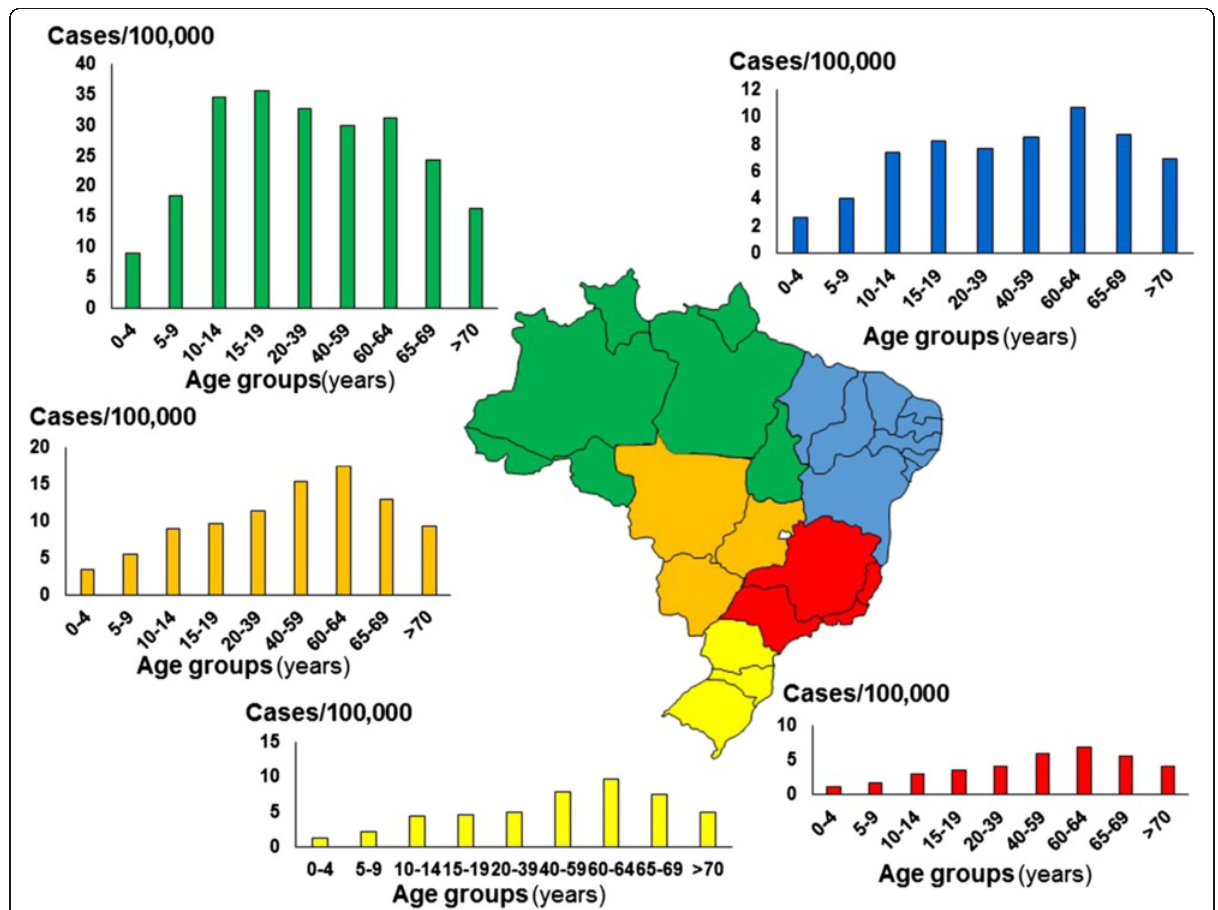
Fig. 4 Age-specific snakebite incidence (per 100,000 people) in Brazil according to age group and